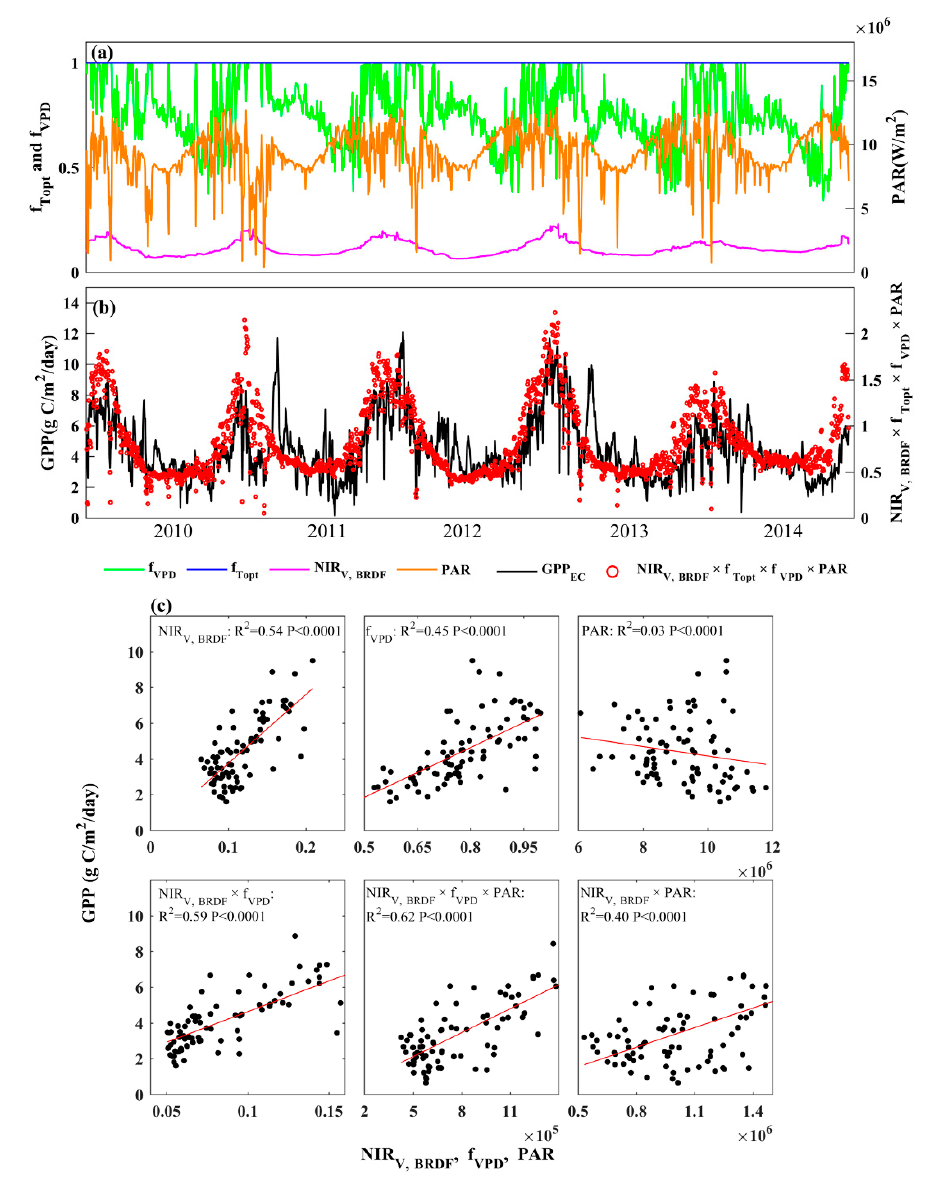
Figure 12. The seasonal cycles and relationship of tower GPP, two environmental scalars (f Topt and f VPD ), and PAR at the Daly River Savanna site (AU-Das, Australia) from 2010 to 2014: ( a ) environmental scalars (f Topt and f VPD ) and PAR; ( b ) NIR V, BRDF × f Topt × f VPD × PAR and tower GPP; ( c ) relationships of tower GPP with NIR V, BRDF , f VPD , and PAR as well as NIR V, BRDF combined with environmental factors.